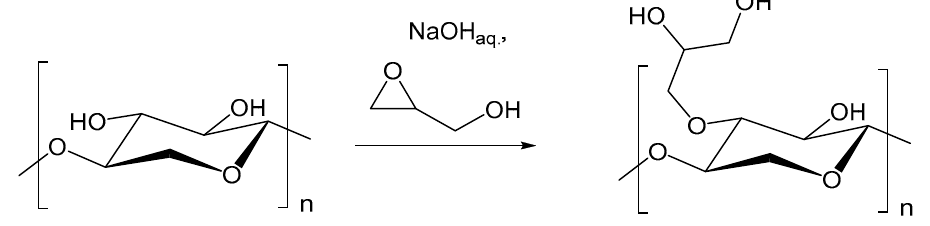
Figure 2. Reaction scheme of the preparation of dihydroxypropyl xylan. Table 1. Results of synthesis of dihydroxypropyl xylan, dependant on the method (EProH = 2,3-epoxy-1-propanol).